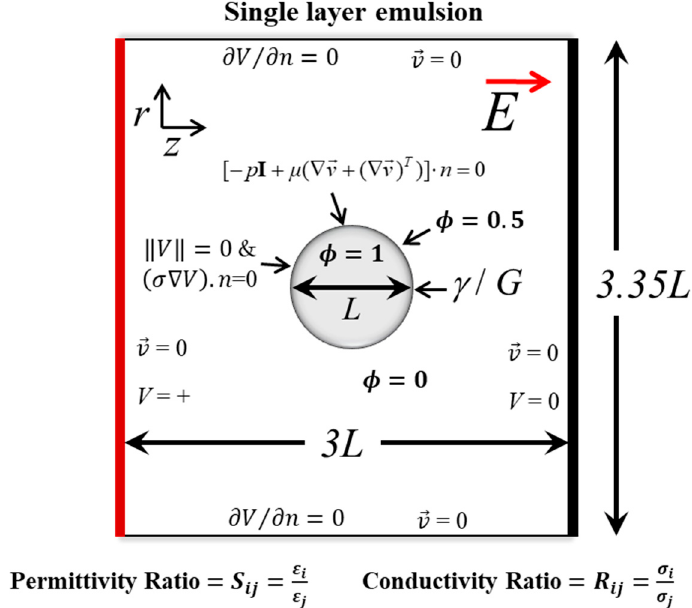
Figure 2. Numerical domain with the boundary conditions for studying the deformation dynamics of particle-free and particle-covered droplets subjected to an electric field 𝐸(cid:4652)⃗ . L is the droplet/suspension diameter. The voltage (V) is applied at the right side and at left side is grounded (V = 0). The top and bottom are electrically insulated ( ∂ V / ∂ n = 0 ) . No slip boundary condition ( 𝑣⃗ = 0 ) is applied at all the walls. The phases are represented by a value of level set function ( 𝜙 ); 𝜙 = 0 for a continuous and 𝜙 = 1 for a dispersed phase. At the interface, the initial fluid interface condition (cid:4670)−𝑝𝐼 + 𝜇(𝛻𝑣⃗ + (𝛻𝑣⃗) (cid:3021) )(cid:4671).𝑛 = 0 for fluid flow, and the continuity of electric potential ( ‖𝑉‖ = 0) and the continuity of electric current (cid:4670)(𝜎𝛻𝑉).𝑛 = 0(cid:4671) for electrostatics were imposed. Here, S is the permittivity ratio, R is the conductivity ratio and 𝛾 is the interfacial tension. The subscript “i” and” j” are used to denote the liquid component at the inside and outside of the droplet, respectively. For a particle-covered droplet, 𝛾 is replaced by a shear elastic modulus, G.